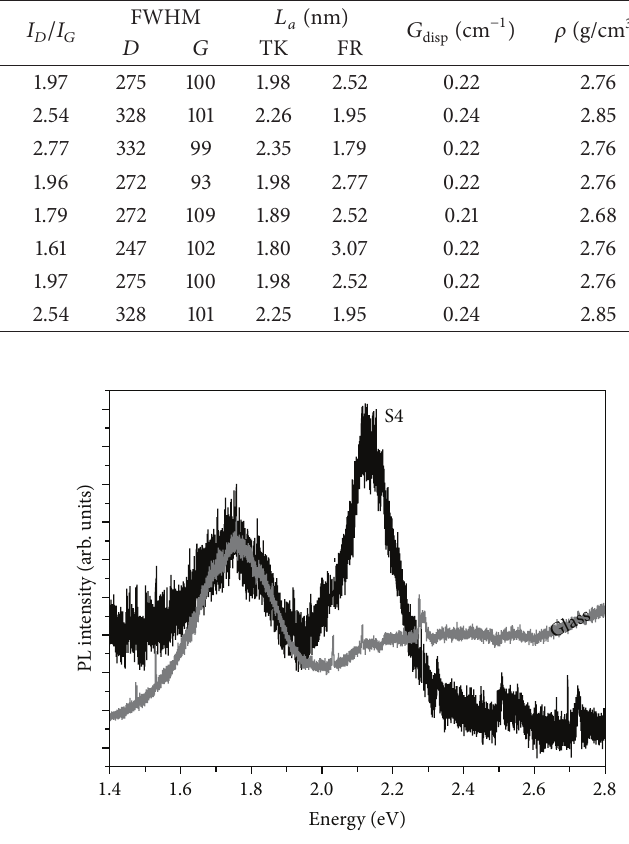
Figure 1: Room temperature PL spectra of 𝛼 -CN 𝑥 films deposited on glass as substrate.